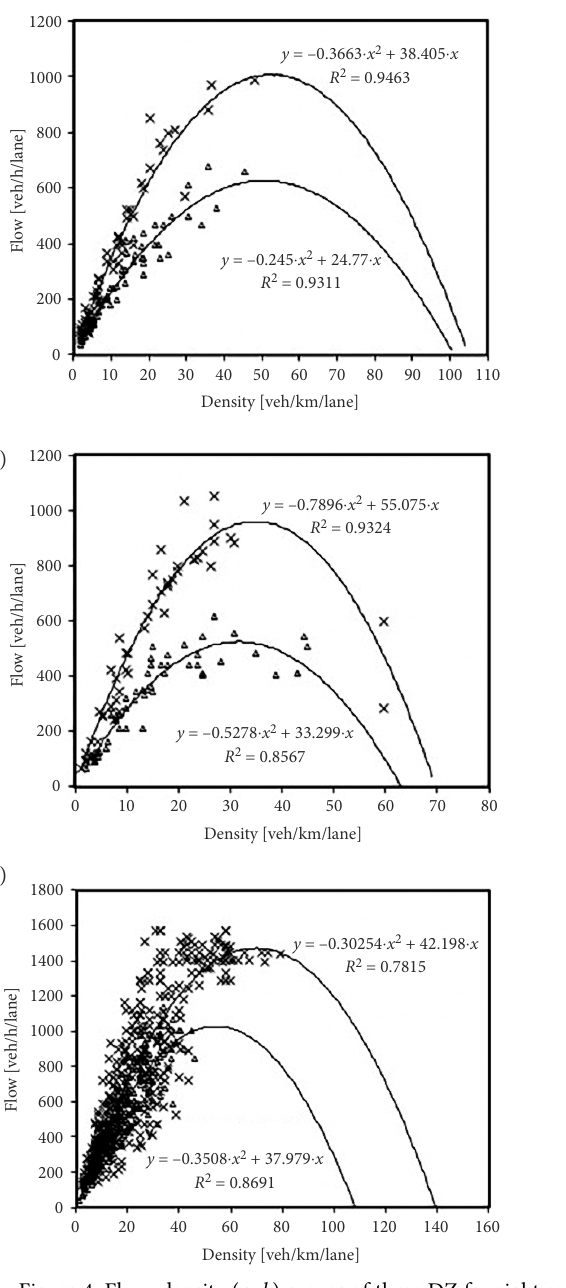
Figure 4. Flow–density ( q – k ) curves of three DZ for right and left lane before deformed and on the deformed